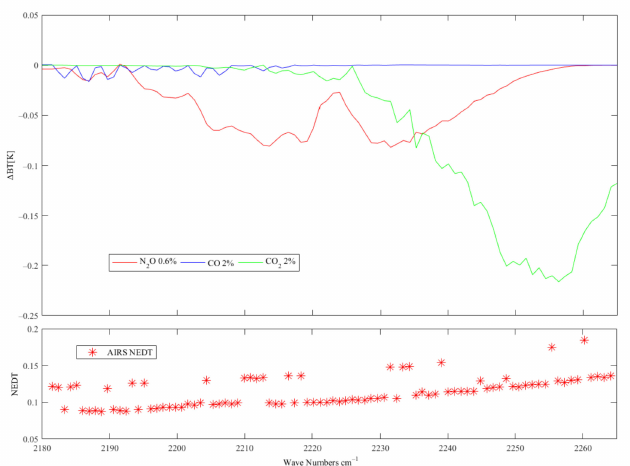
Figure 5. Changes in BT near the υ 3 absorption band of N 2 O that occur when the CO 2 , N 2 O, and CO concentrations increase by 2%, 0.6%, and 2%, respectively, (top) and AIRS channel noise in the υ 3 absorption band of N 2 O